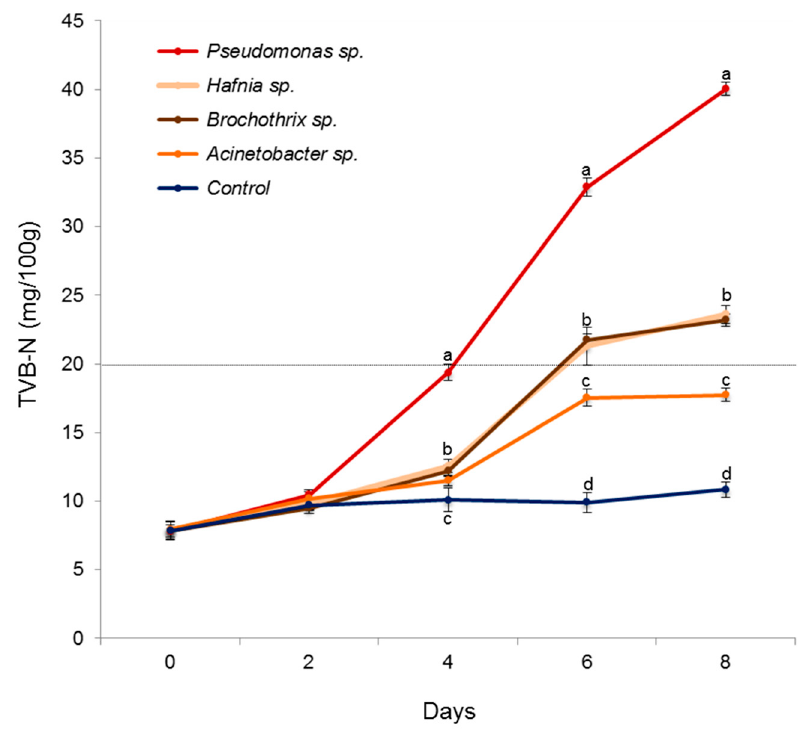
Figure 3. Spoilage potential of SSO candidates obtained from spoiled chicken meat. Fresh decontaminated meat samples were inoculated (~4.0 log CFU / g) with either Pseudomonas sp. , Brochothrix sp., Hafnia sp., Acinetobacter sp., or sterile saline solution (negative control) and stored at 4 ◦ C across 8 days. Total volatile basic nitrogen (TVB-N) > 20 mg / 100 g (pointed gray line) was used as an indicator of meat spoilage. Graph depicts mean values and their standard errors from three independent experiments. Different letters are significantly different ( p < 0.05). Statistical analysis was performed by means of ANOVA Fisher’s protected least significant difference